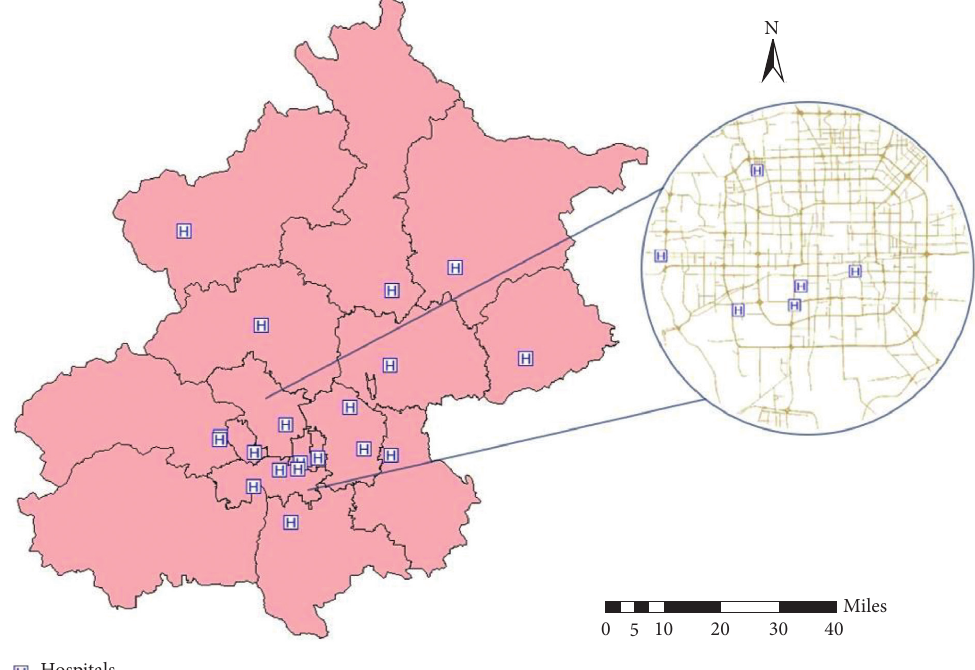
Figure 13: The spatial distribution of the designated